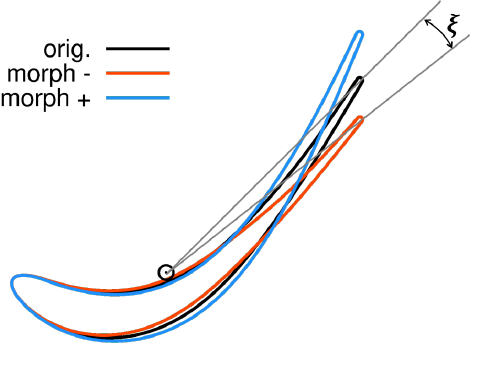
Figure 2. Shape morphing